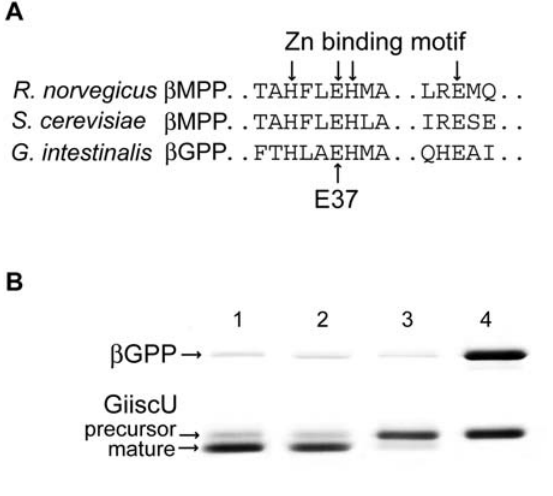
Figure 3. The b GPP is a metallopeptidase with a similar cleavage mechanism to a / b MPP. ( A ) Alignment of b GPP and b MPP subunit showing the conserved zinc-binding motif. ( B ) Effect of protease inhibitors and mutation of E37 on the activity of b GPP. Lane 1: b GPP + GiiscU showing cleavage to produce the mature protein; lane 2: b GPP + GiiscU + serine and cysteine protease inhibitors showing no inhibition; lane 3: b GPP + GiiscU + EDTA showing inhibition of cleavage; lane 4: Mutant b GPP in which E37 was mutated to glutamine + GiiscU, showing that the mutation of a key residue for b MPP activity also eliminates b GPP